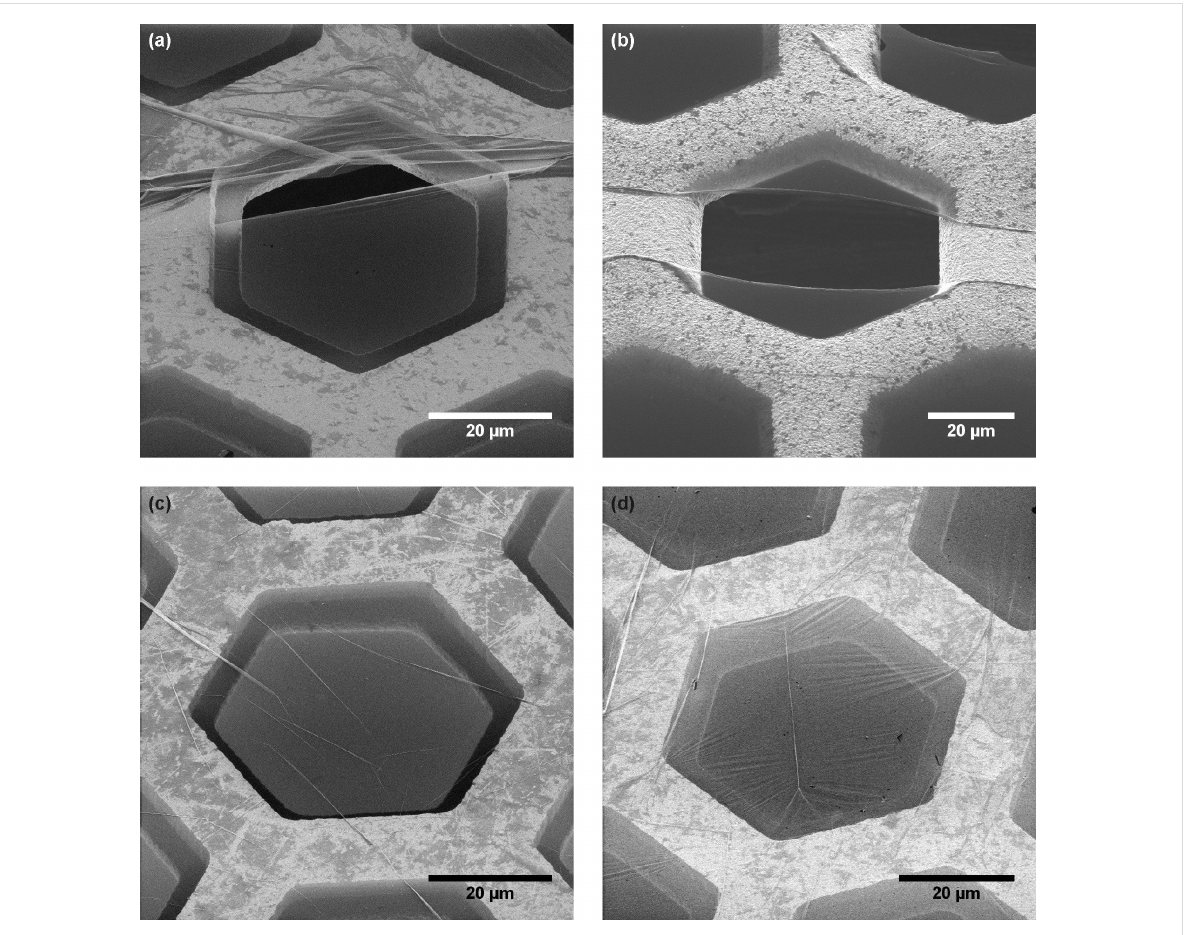
Figure 2: Examples of CNMs which were transferred onto copper grids with hexagonal openings. Different types of features are visible: (a) larger folds; (b) rolled CNM edges; (c) small folds; and (d) wrinkled CNMs. Detailed information on all HIM images is given in Supporting Information File 1, Tables S1 and